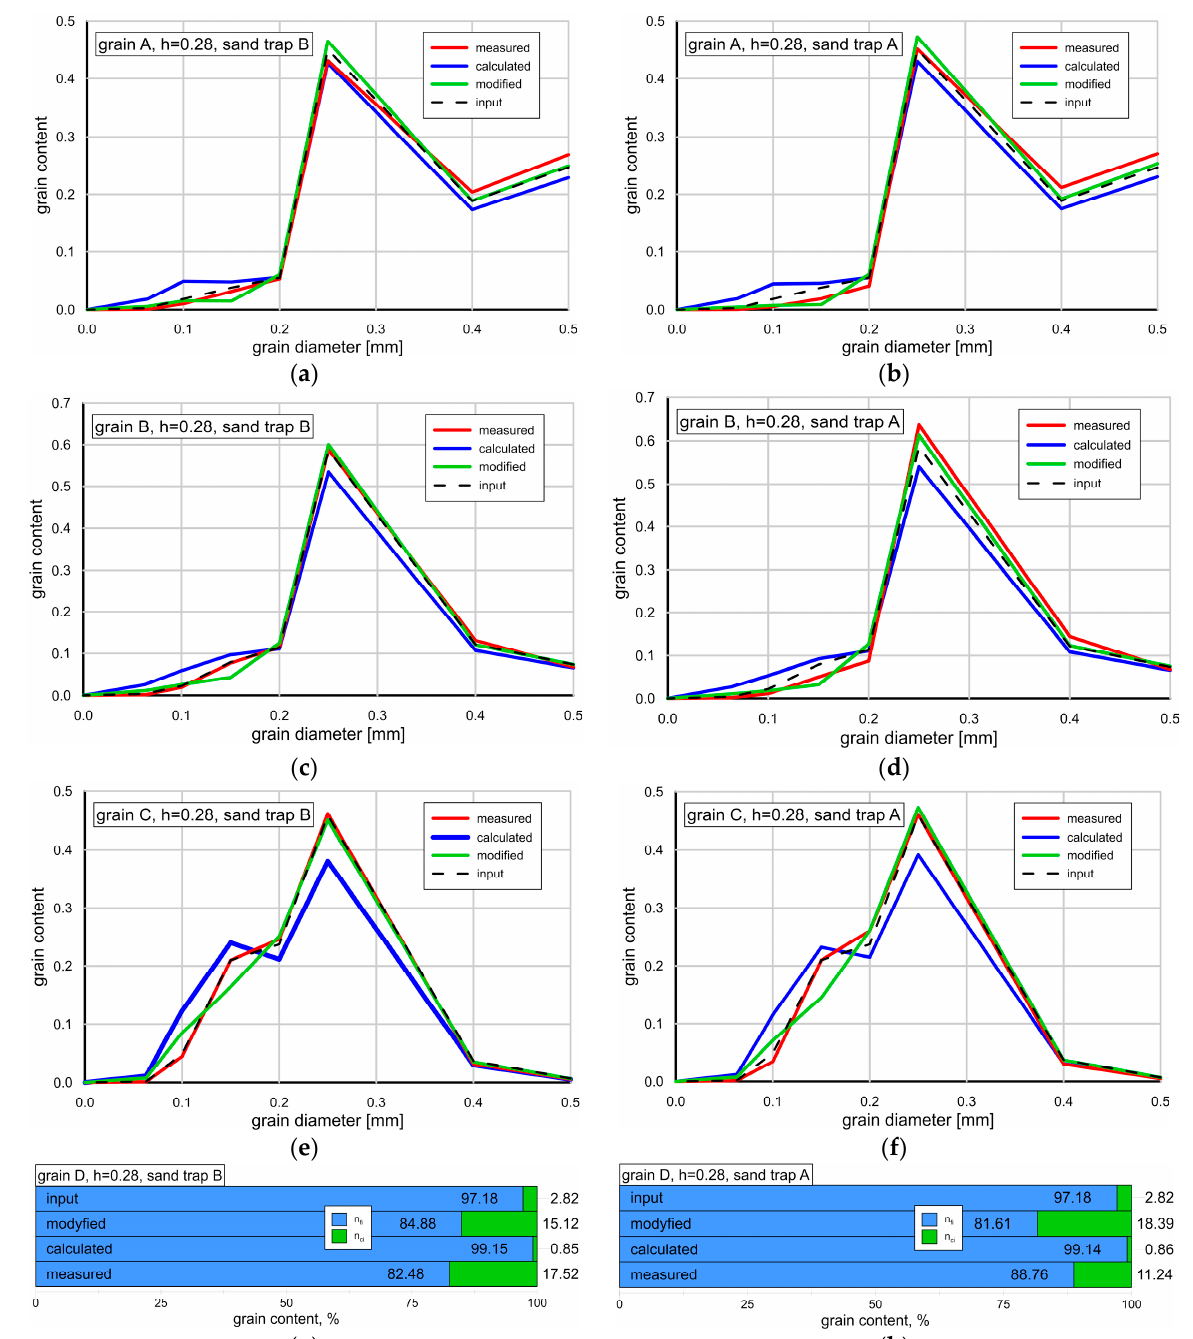
Figure 13. Comparison of calculated and measured grain size distributions in fine fractions and coarse fractions in sloped bed case: ( a ) sand A—crest; ( b ) sand A—trough; ( c ) sand B—crest; ( d ) sand B—trough; ( e ) sand C—crest; ( f ) sand C—trough; ( g ) sand D—crest; ( h ) sand D—trough.